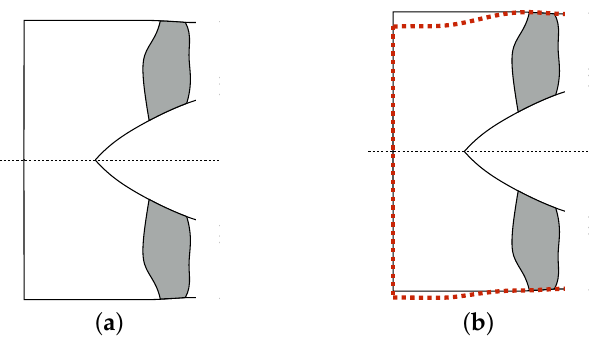
Figure 3. Air inlet duct geometries. ( a ) Axisymmetric air inlet; ( b ) asymmetric air